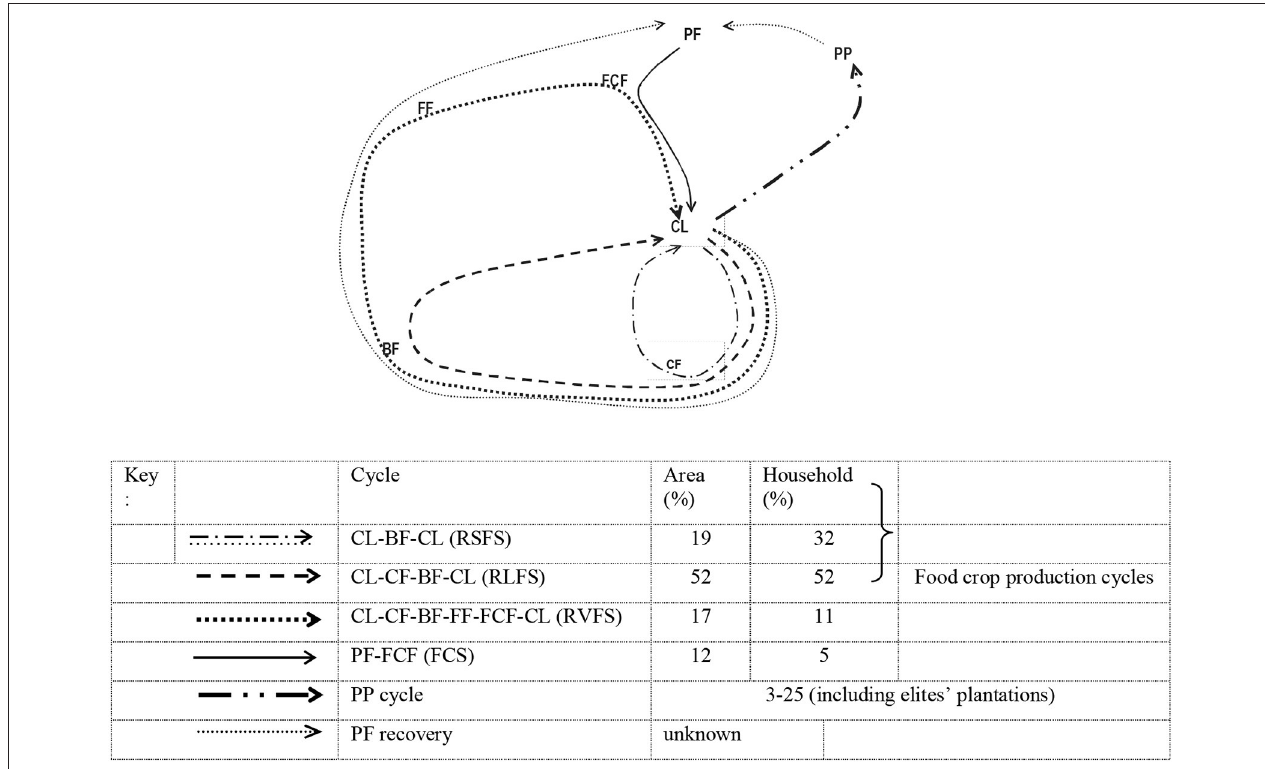
FIGURE 4 | Cycle proportions of shifting agricultural land use management in southern Cameroon. Adapted and modified from Yemefack (2005, Chapter 2). CF, Chromolaena Fallow of 3–5 year-old; BF, Bush Fallow of 7–9 year-old; FF, Forest Fallow of > 15 year-old; CL, Crop Land, coded: CL1 = at the beginning and CL2 = at the end of cropping 2 years after); FCF, Forest Crop Field of 1–2 year-old; PP, Perennial plantation, PPm = less than 7-year-old and PPo = more than 30 year-old; PF, Primary Forest.